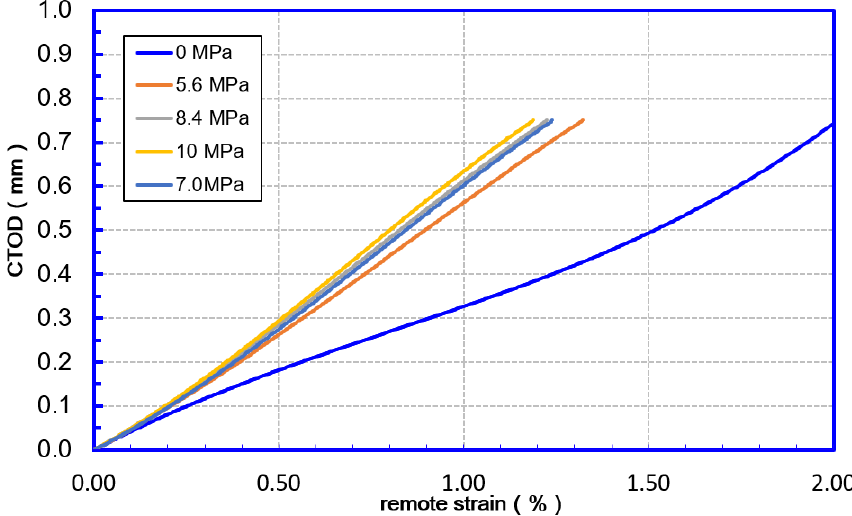
Figure 14. Internal pressure effects on CDF 12.8 mm — 12.8 mm WT.